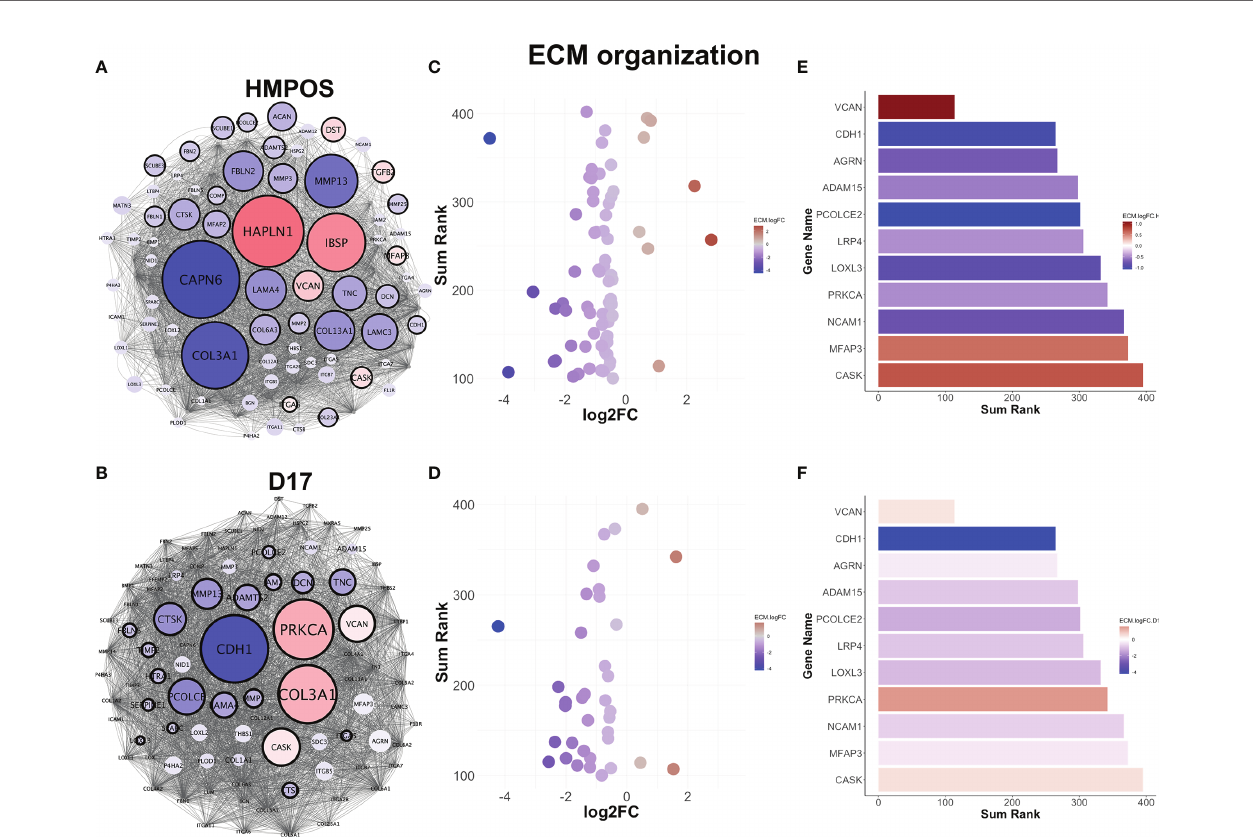
FIGURE 3 | Extravasated circulating tumor cells downregulate extracellular matrix remodeling. (A) Gene regulatory networks for the extracellular matrix remodeling pathway in HMPOS and (B) . D17. Blue denotes downregulation and red denotes upregulation (FDR < 0.05). Nodes are scaled proportionally to log2FC, with larger nodes depicting greater log2FC between extravasated and parental cell lines. (C) Scatter plot of sum rank of network connectivity parameters by log2FC for HMPOS and (D) D17. (E) Bar graphs of top connected genes in the pathway, colored by log2FC for HMPOS and (F)